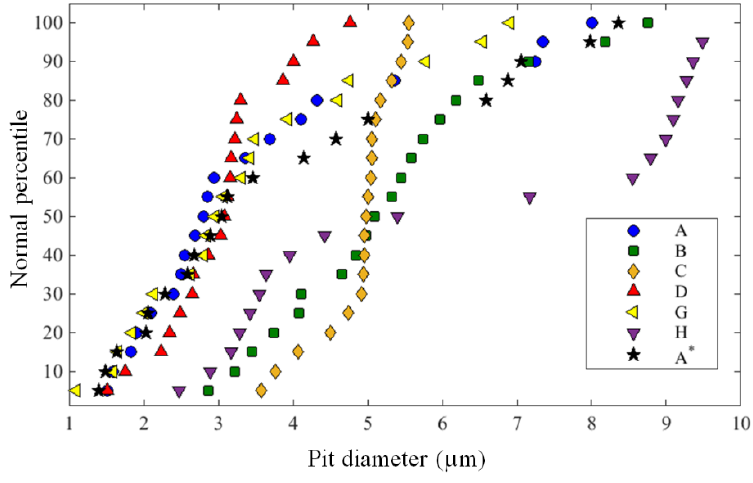
Figure 5. Etch pit diameter measured out of several SEM images from each prepared in-situ etched GaN seed.